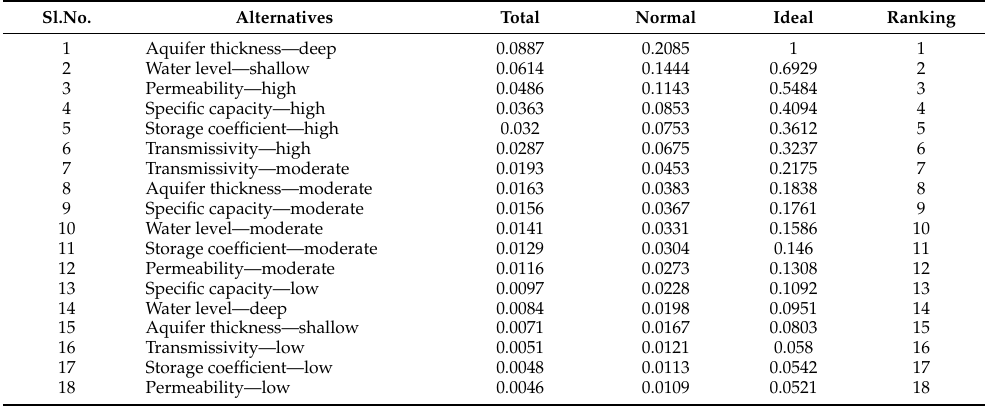
Figure 6. Groundwater potential zone maps based on ( a ) surface parameters, ( b ) subsurface parameters, and ( c ) amalgamated parameters along with geo-positions of inventory wells. Table 4. Ideal values and the overall ranking of subsurface parameters derived through supermatrix